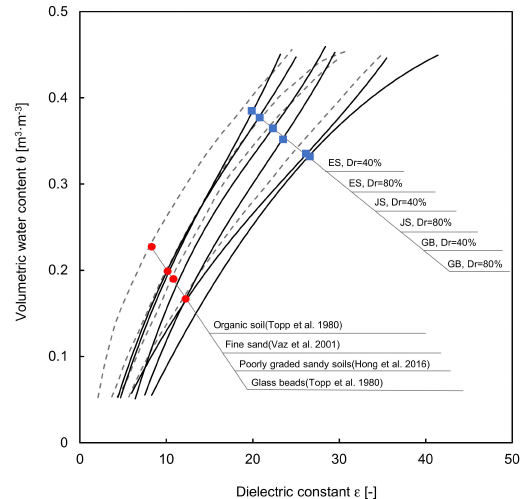
Figure 6. The calibration results between the dielectric constant and saturation. GB, JS, and ES denote the glass beads, Jumunjin sand, and the extracted